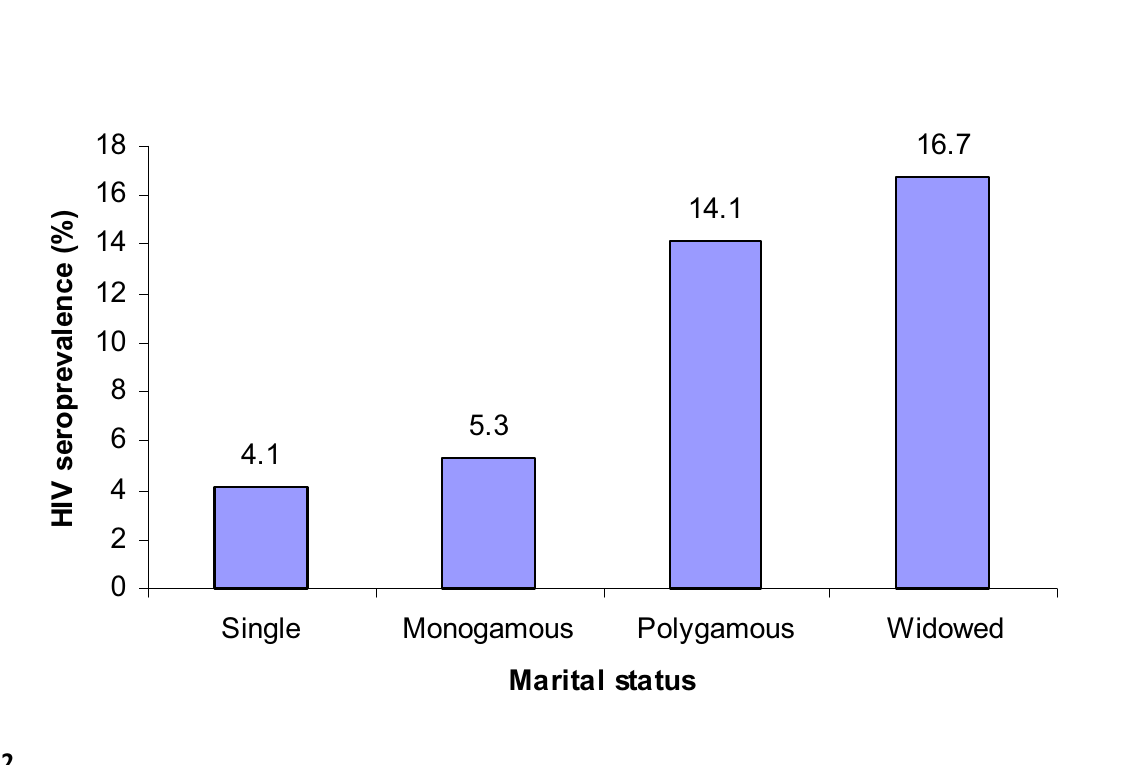
Figure 1 HIV Prevalence by age group .